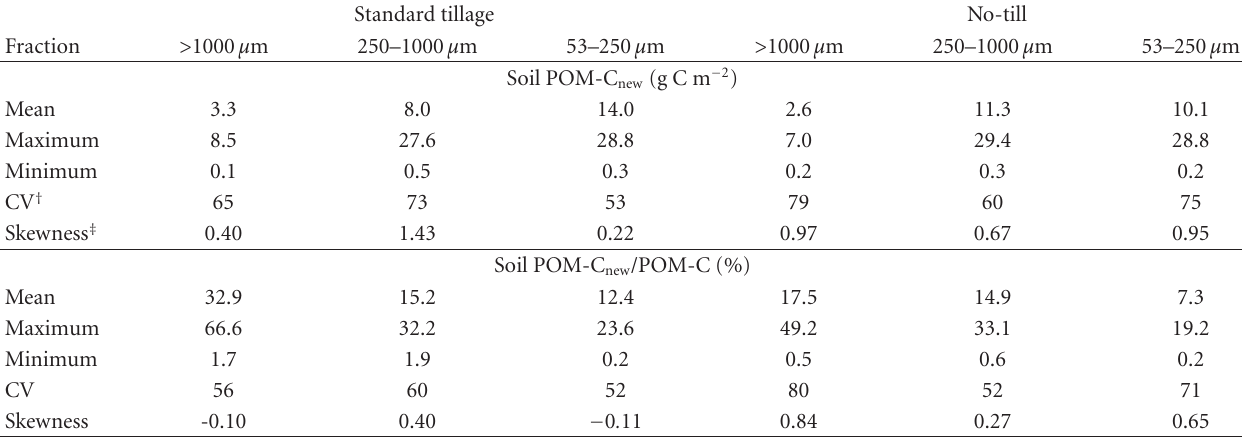
Table 5: Wheat-derived C and proportion of wheat-derived C/total fraction C in POM fractions under standard tillage and no-till in the first eight months of